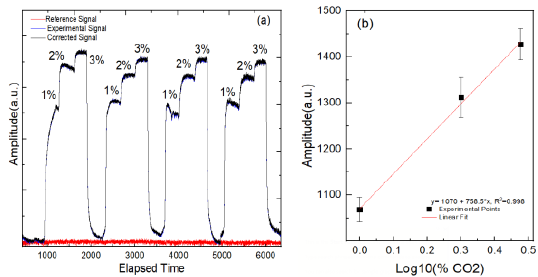
Fig. 3. (a) Sensor reaction with different CO 2 concentrations (1%, 2% and 3%). Experimental signal is used as a measurement signal, and Reference signal was used to correct of any external fluctuations (b) Sensor calibration curve plotted as a function of the logarithm percentage of CO 2